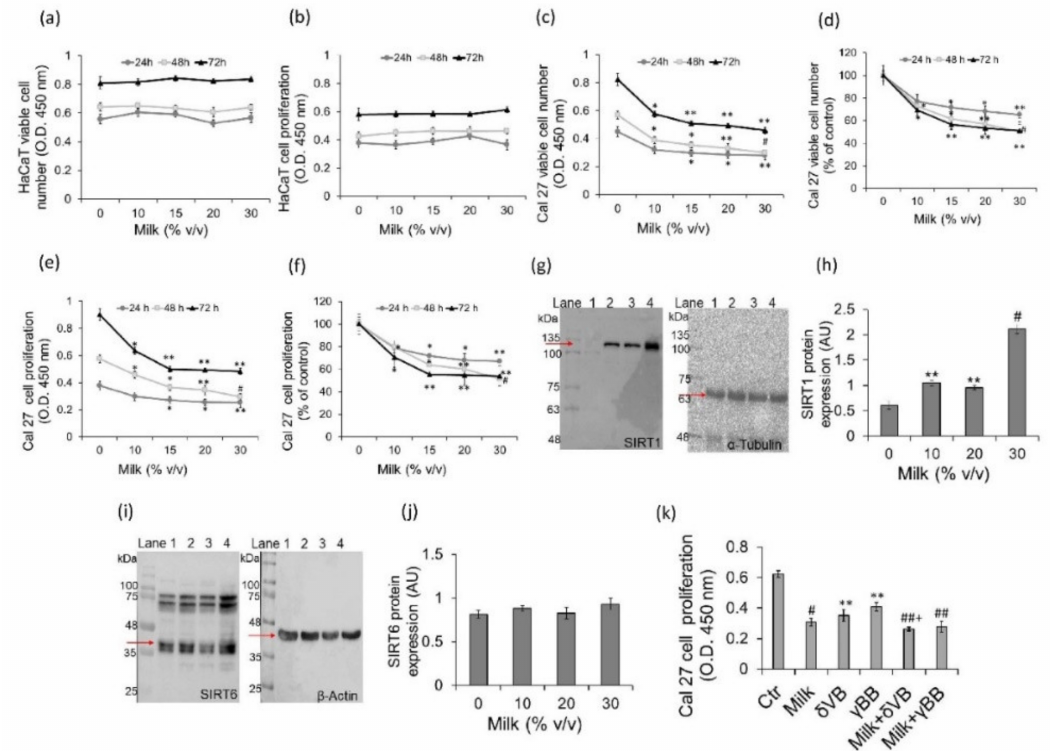
Figure 1. E ff ect of milk on cell viability, proliferation and sirtuins. Milk was centrifuged at 3000 × g for 15 min at 4 ◦ C to remove fat globules. Skimmed milk was then filtered through a 5 µ m Millipore filter followed by filtration through an Amicon Ultra 0.5 mL centrifugal filter with a 3-kDa molecular weight cut-o ff . Before being used, milk extracts were filtered through 0.22 µ m Millipore filters. Enrichment of milk was performed by adding 2 mM δ VB or 2 mM γ BB ( a – f ) Cells were treated with increasing volumes of milk (up to 30% v / v ) for 0, 24, 48, and 72 h. Control cells were grown in medium containing the same volume (% v / v ) of HBSS-10 mM Hepes. Cells viability and proliferation were assessed by Cell Counting Kit-8. The optical density (OD) values at time 0 h did not di ff er among treatments with milk (from 0 up to 30% v / v ); mean values were ( a ) 0.483 ± 0.0097 ( b ) 0.298 ± 0.017, ( c ) 0.263 ± 0.019 ( e ) 0.217 ± 0.021. ( g , h ) SIRT1 and ( i , j ) SIRT6 protein expression levels in Cal 27 cells after 48 h of treatment with milk. Lane 1 = Ctr, lane 2, milk 10% v / v , lane 3 = milk 20% v / v , lane 4 = milk 30% v / v . ( k ) Cal 27 cell proliferation performed after 48 h of treatment with milk (30% v / v ) supplemented with 2 mM δ VB or 2 mM γ BB. Results are expressed as arbitrary units (AU) with * p < 0.05 vs. Ctr, ** p < 0.01 vs. Ctr, # p < 0.001 vs. Ctr, ## p < 0.0001 vs. Ctr, + p < 0.05 vs.